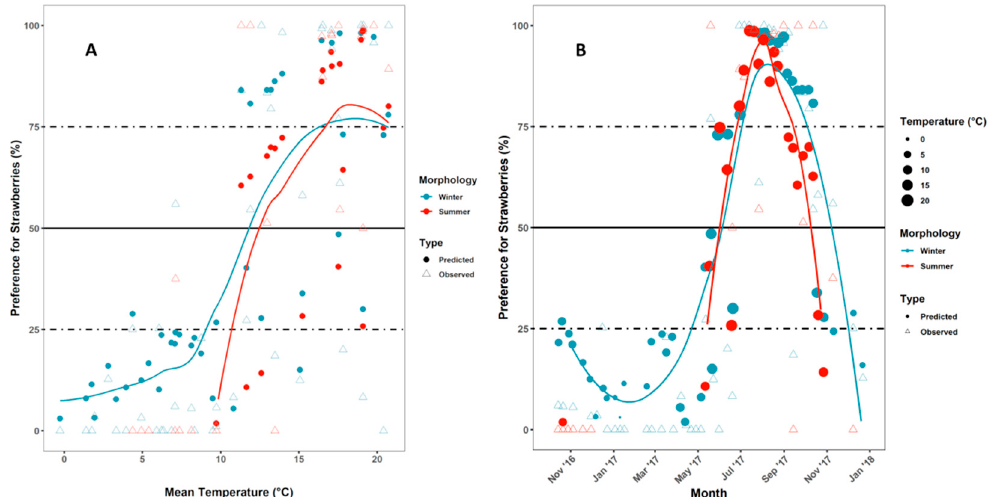
Figure 4. A field preference experiment was done from the 14th of October 2016 till the 22nd of December 2017. Dots are the estimated values from the model, triangles the actual observations. The line is a local regression line (LOESS) and does not represent the underlying logistic function. ( A ) Preference for strawberry (over ACV) in relation with the mean temperature during the trapping interval and ( B ) preference for strawberry (over ACV) over the year. For B, the size of the dot relates to the mean temperature during the interval preceding the corresponding sampling date.